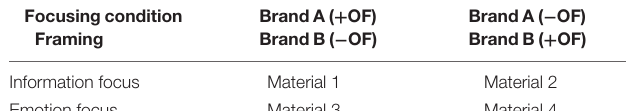
TABLE 2 | Material allocations Focusingcondition